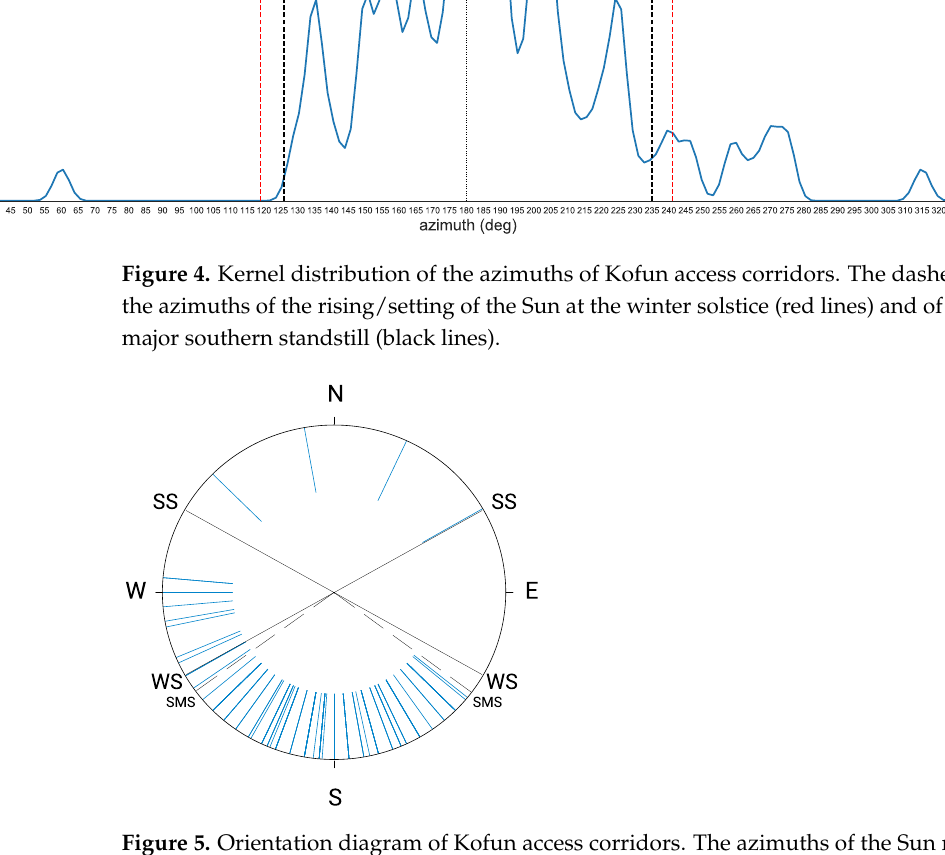
Figure 5. Orientation diagram of Kofun access corridors. The azimuths of the Sun rising/setting at the winter solstice (WS) and those of the Moon at the southern major standstill (SMS) are marked.